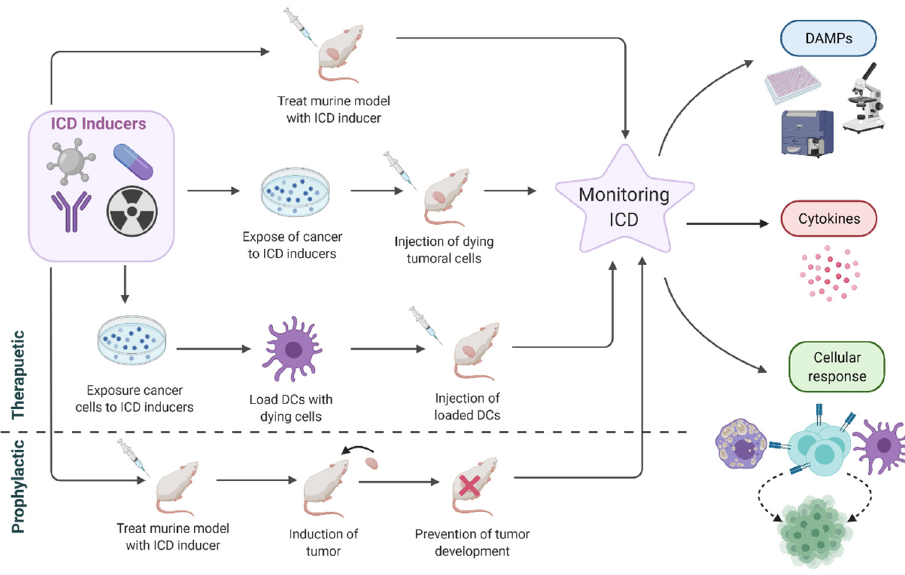
Figure 9. Schematic protocols to monitor ICD in TME.